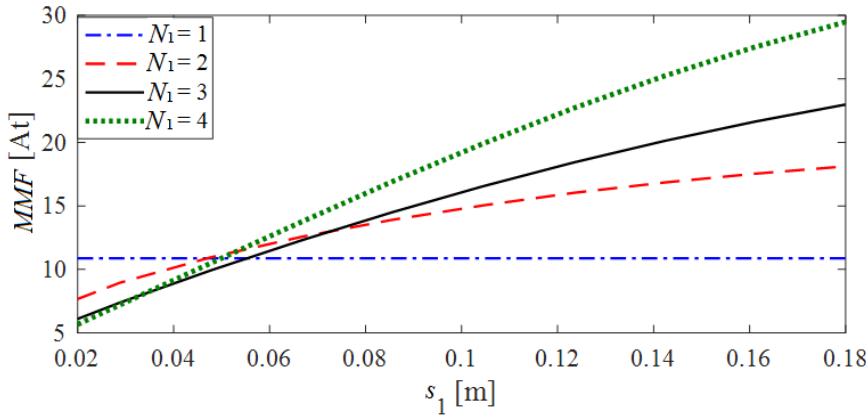
Figure 6. MMF 1 versus intraturn spacing s 1 that produces maximum admissible SAR = 2 W/kg inside human torso.